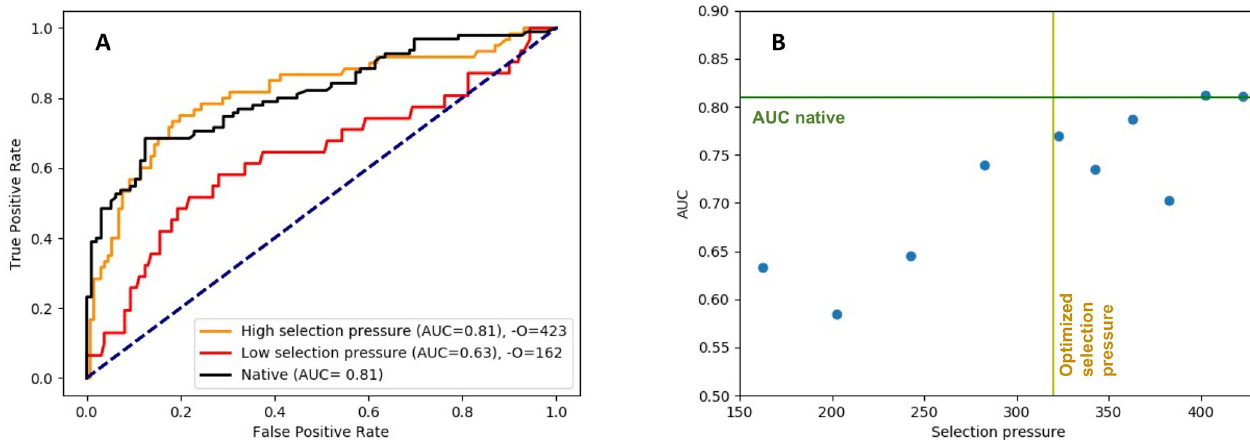
Fig 5. ROC curve for residue-residue contact prediction. A) Comparison of ROC curve for natural sequences (black) and two simulated alignments (red and orange) at two different reference energies. The blue line shows the diagonal. B) Dependence of contact-prediction accuracy (AUC) on selection pressure. The green line corresponds to AUC for the natural sequence. The yellow line corresponds to the selection pressure that gives the optimal correspondence between predicted and empirical amino acid substitution rates in a Rosetta-based rate prediction method [14,33].